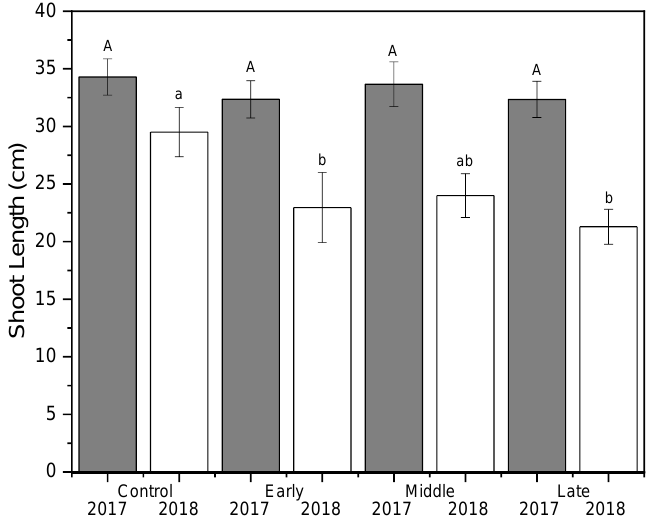
Figure 2. Mean shoot growth (cm) (±SE; n = 3) of ‘Honeycrisp’ apple under deficit irrigation in 2017 (gray) and 2018 (white). Four treatments were established including a well-watered control, early season deficit (16 – 45 days after full bloom [DAFB]), mid – season deficit (46 – 75 DAFB), and late season deficit (76 – 105 DAFB). Uppercase letters denote significance among treatments for 2017 and lowercase letters denote significance among treatments for 2018.